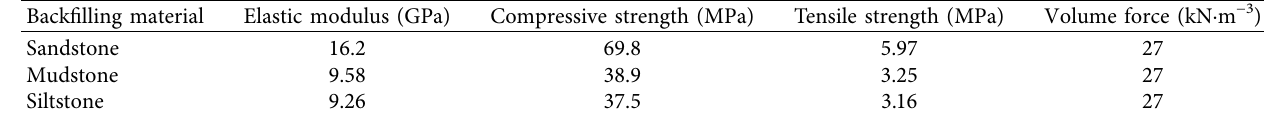
Figure 9: Grid model of numerical calculation based on FLAC 3D software. Table 3: Physical and mechanical parameters of backfilled gangue.